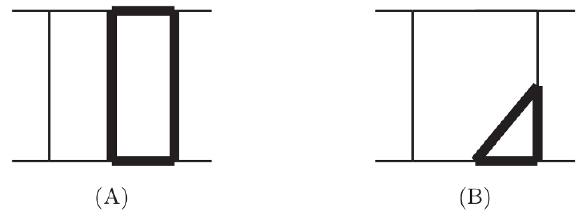
Figure 1 . Seven-denominator topologies. Thin lines represent external massless particles and propagators, while thick lines represent massive